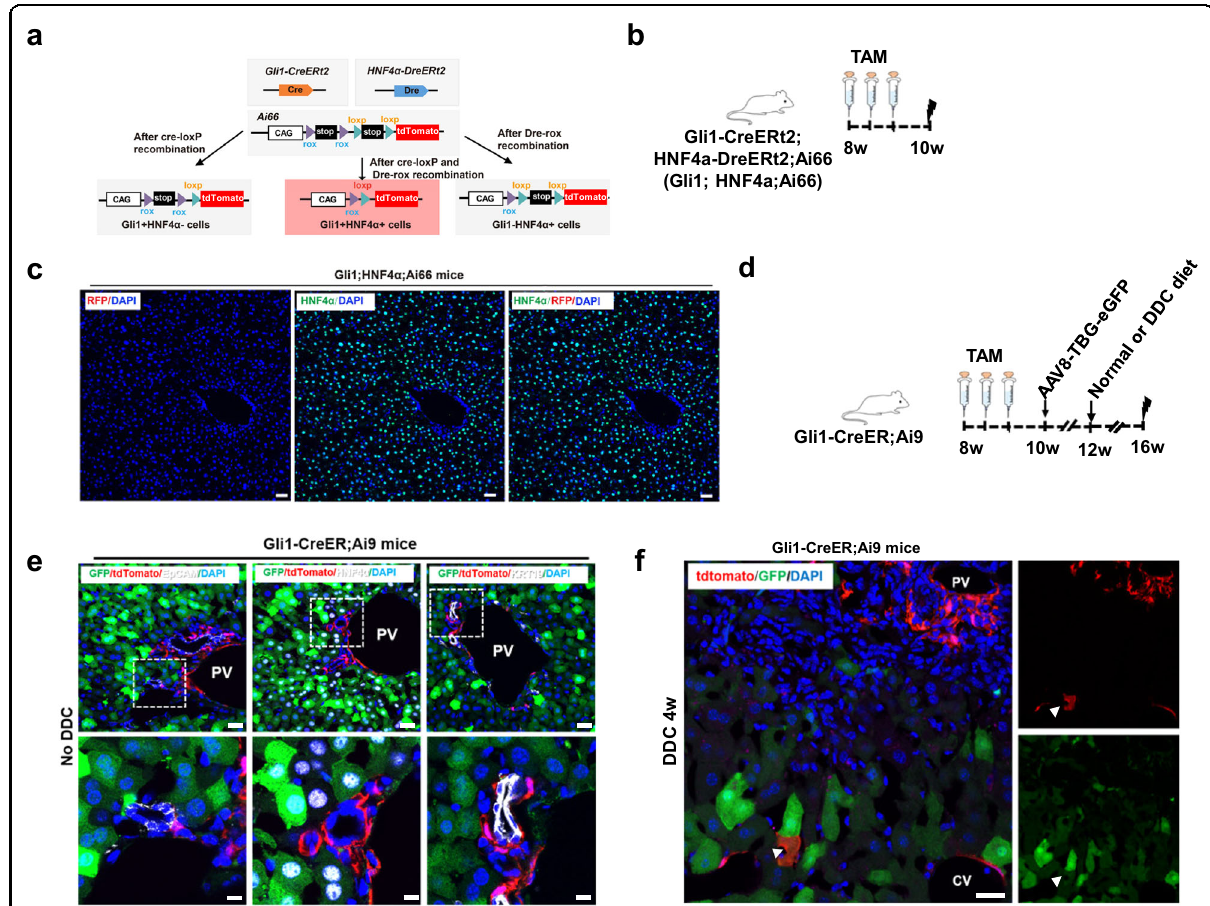
Fig. 2 Hepatocytes derived from Gli1 + nonhepatocytes upon chronic injury. a Schematic diagram showing the strategy for labeling Gli1 + HNF4 α + cells by a dual recombinase-mediated intersectional genetic approach. b Schematic illustration of the experimental design. c Immunostaining for tdTomato (red) and HNF4 α (green) in representative liver sections after DDC-induced injury. Scale bars, 50 μ m. d Schematic illustration of the experimental design. e Immunostaining for GFP (green), tdTomato (red) and EpCAM (white), HNF4 α (white) or KRT19 (white) in liver sections from Gli1-Cre ERt2 ;Ai9 mice. PV portal vein. Scale bars, 50 μ m. f Immunostaining for GFP (green) and tdTomato (red) in liver sections from Gli1- Cre ERt2 ;Ai9 mice after DDC-induced injury and AAV8-TBG-GFP viral particle injection. White arrowheads indicate hepatocyte morphology. Scale bar, 50 μ